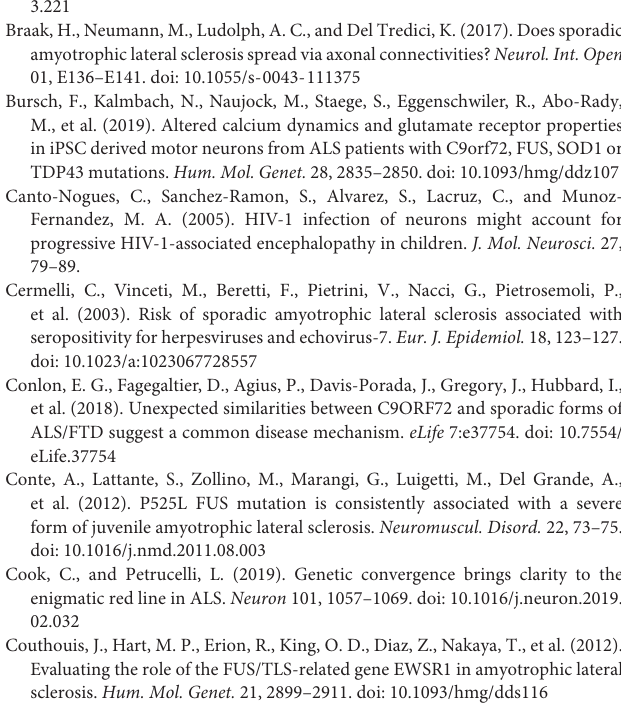
FIGURE S3 | Direkt infection of LL and SL FUS-eGFP WT spinal neurons with RABV (cid:49) G-mCherry. 2 days following infection, FUS-WT spinal neurons show stress granules, and 7 days following infection, FUS-WT spinal neurons show RABV (cid:49) G-mCherry transgene expression. Scale bar = 25 µ m. FIGURE S4 | Proteasomal inhibition increases RABV (cid:49) G-mCherry levels and neurodegeneration. (A) Diagram illustrating infection of iPSC-derived spinal neurons with RABV (cid:49) G in the presence of 2.5 µ M MG-132. (B,C) RABV (cid:49) G-mCherry levels are increased in iPSC-derived spinal neurons with LL WT FUS-eGFP at 2 days following infection of spinal neurons in presence of the proteasome inhibitor MG-132. (D,E) Cleaved-Caspase3 (CC3) levels are increased in iPSC-derived spinal neurons with LL WT FUS-eGFP at 2 days following infection of spinal neurons in presence of the proteasome inhibitor MG-132. Scale bar = 25 µ m. n = 3. Error bars indicate SEM. ∗ and ∗∗ correspond to p < 0.05 and 0.01, respectively. LL, long linker; MUT, mutant; WT, wild type. FIGURE S5 | FUS-eGFP-positive SGs form following arsenite treatment but not HIV-1 or ZIKV infection. (A) J2 antibody was validated in Vero cells infected with the same viral stocks used in MNs. ZIKV infected Vero cells show colocalization of vRNA, capsid (CA) and TIAR at the nuclear periphery. Scale bar = 10 µ m. (B) FUS-eGFP spinal neurons show FUS-eGFP and G3BP1 positive SGs 1 h after adding 500 µ M arsenite. Scale bar = 5 µ m. (C) Spinal neurons do not show FUS-eGFP granule formation after infection. The G3BP1 and vRNA in ZIKV infected WT-FUS cell colocalizes in cytoplasmic puctae. Co-localized G3BP1 and vRNA, are much more diffuse in the P525L FUS mutant infected by both ZIKV or HIV-1, as it is for HIV-1 infected FUS WT cells. Scale bar = 5 µ m. MOI, multiplicity of infection; DIC, differential interference contrast; CA, ZIKV capsid; LL, long linker; MUT, mutant; WT, wild type; vRNA, viral RNA; /, colocalization. FIGURE S6 | FUS-P525L spinal neurons show increased cytoplasmic vRNA levels (A,B) vRNA levels in FUS-P525L spinal neurons are increased in the cytoplasmic localization at the nuclear periphery after ZIKV or HIV-1 infection in comparison to WT. Scale bar = 10 µ m. ∗ and ∗∗ indicate p < 0.01 and 0.0001, respectively, according to one-way ANOVA, Tukey post-test for multiple comparisons. n = 6. Error bars represent